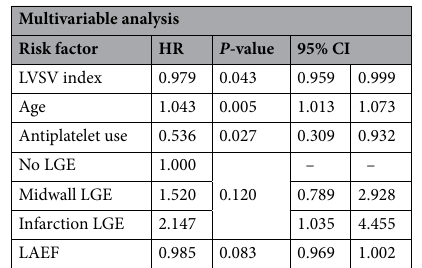
Table 3. Multivariable analysis of the strongest predictors. Multivariable analysis indicating prognostic variables.